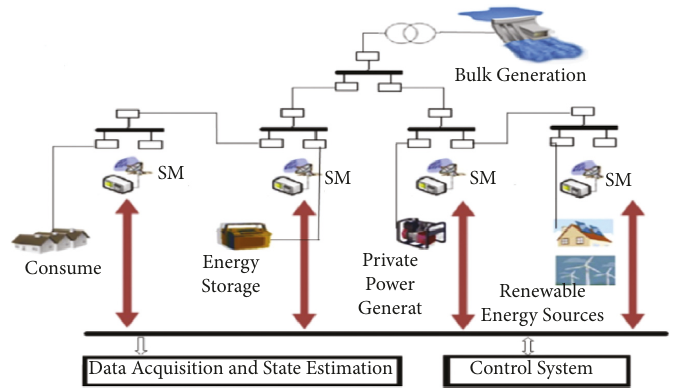
Figure 1: Structure of a smart grid